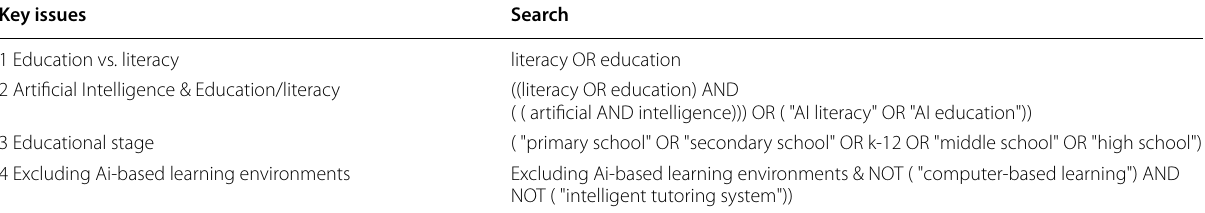
Table 1 Summary of search terms and issues associated with their choice Key issues